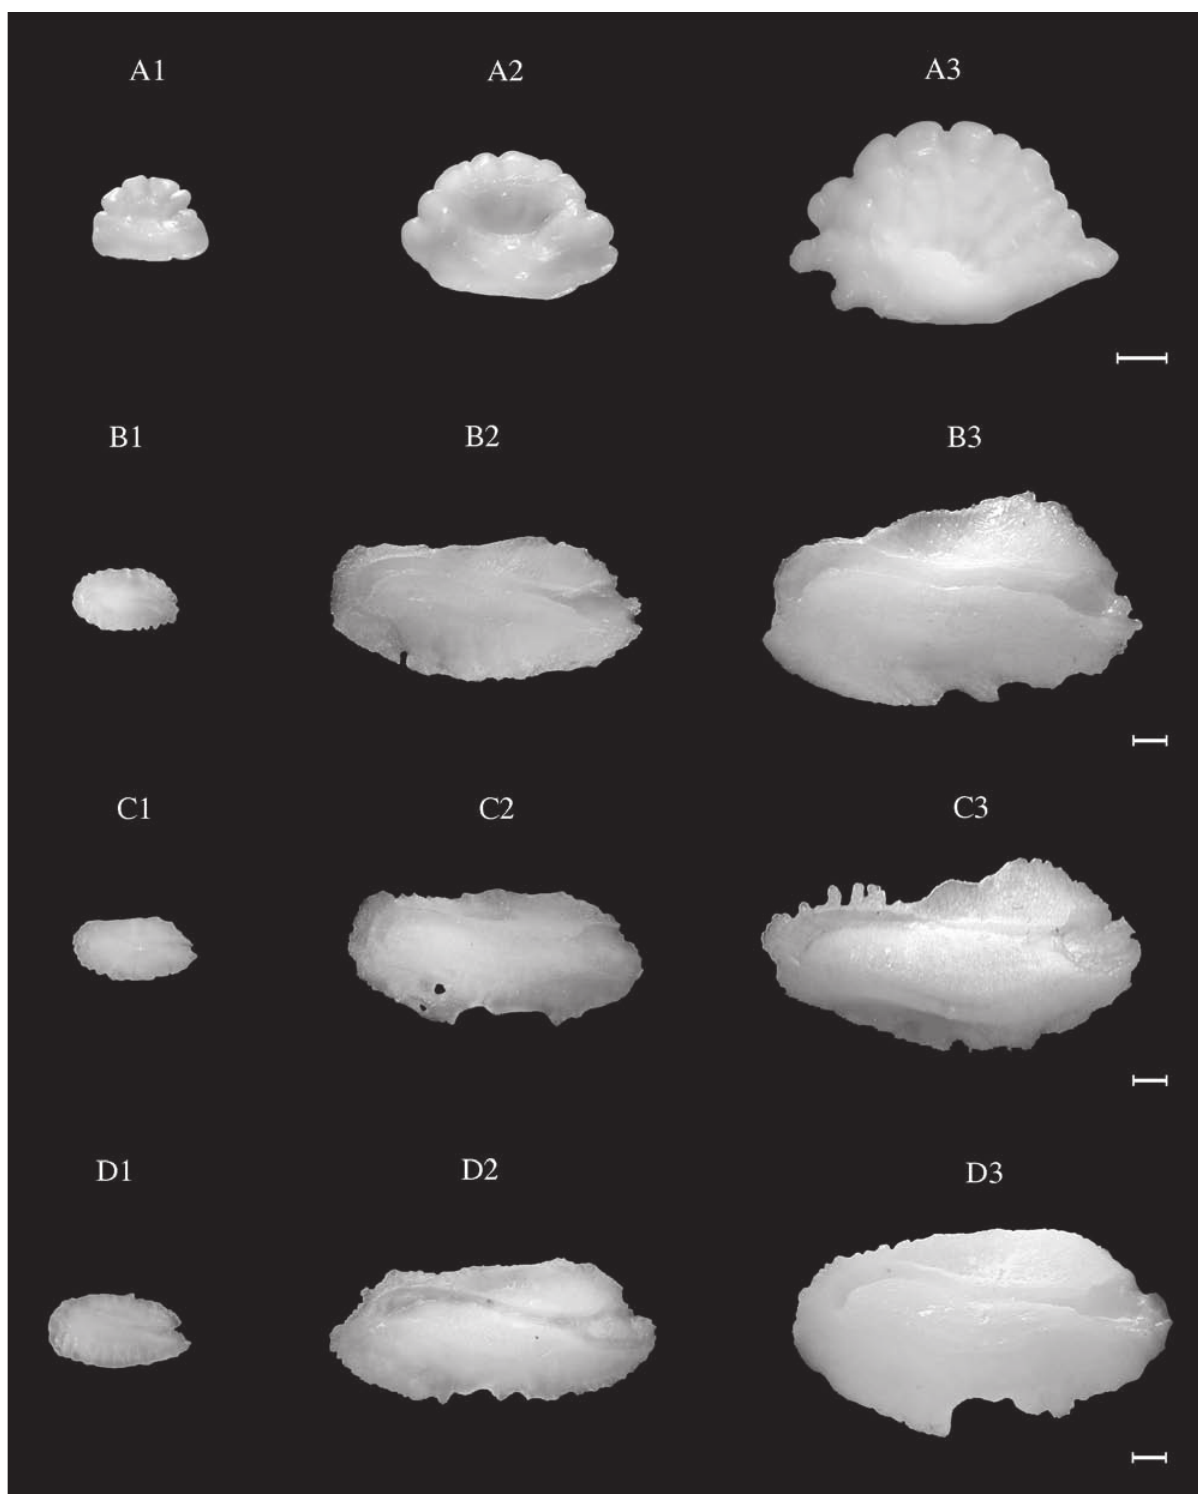
Fig. 35. – Lophius piscatorius . TL: A1, 15.0 cm (WM); A2, 25.0 cm (WM); A3, 45.6 cm (NEA). Chelon labrosus . TL: B1, 10.1 cm (NEA); B2, 37.9 cm (CEA); B3, 53.0 cm (WM). Liza aurata . TL: C1, 101. cm (NEA) ; C2, 33.3 cm (NEA); C3, 58.5 cm (WM). Liza ramada . TL: D1, 12.1 cm (NEA); D2, 37.0 cm (WM); D3, 51.0 cm (WM). Scale bar = 1